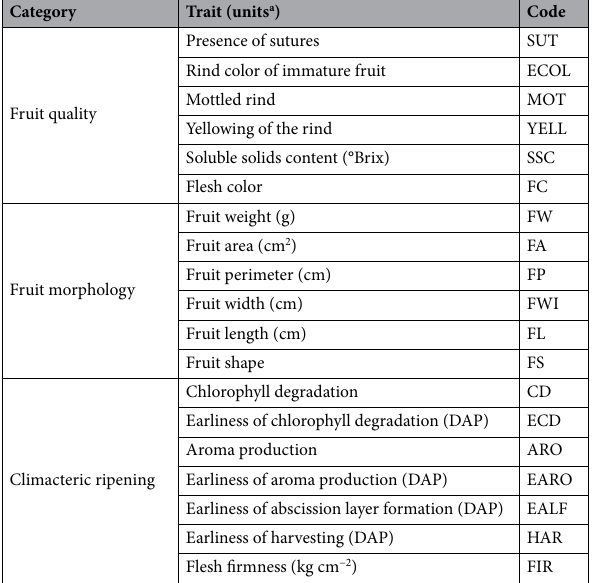
Table 2. Phenotypic traits evaluated in the IL collection. a DAP days after